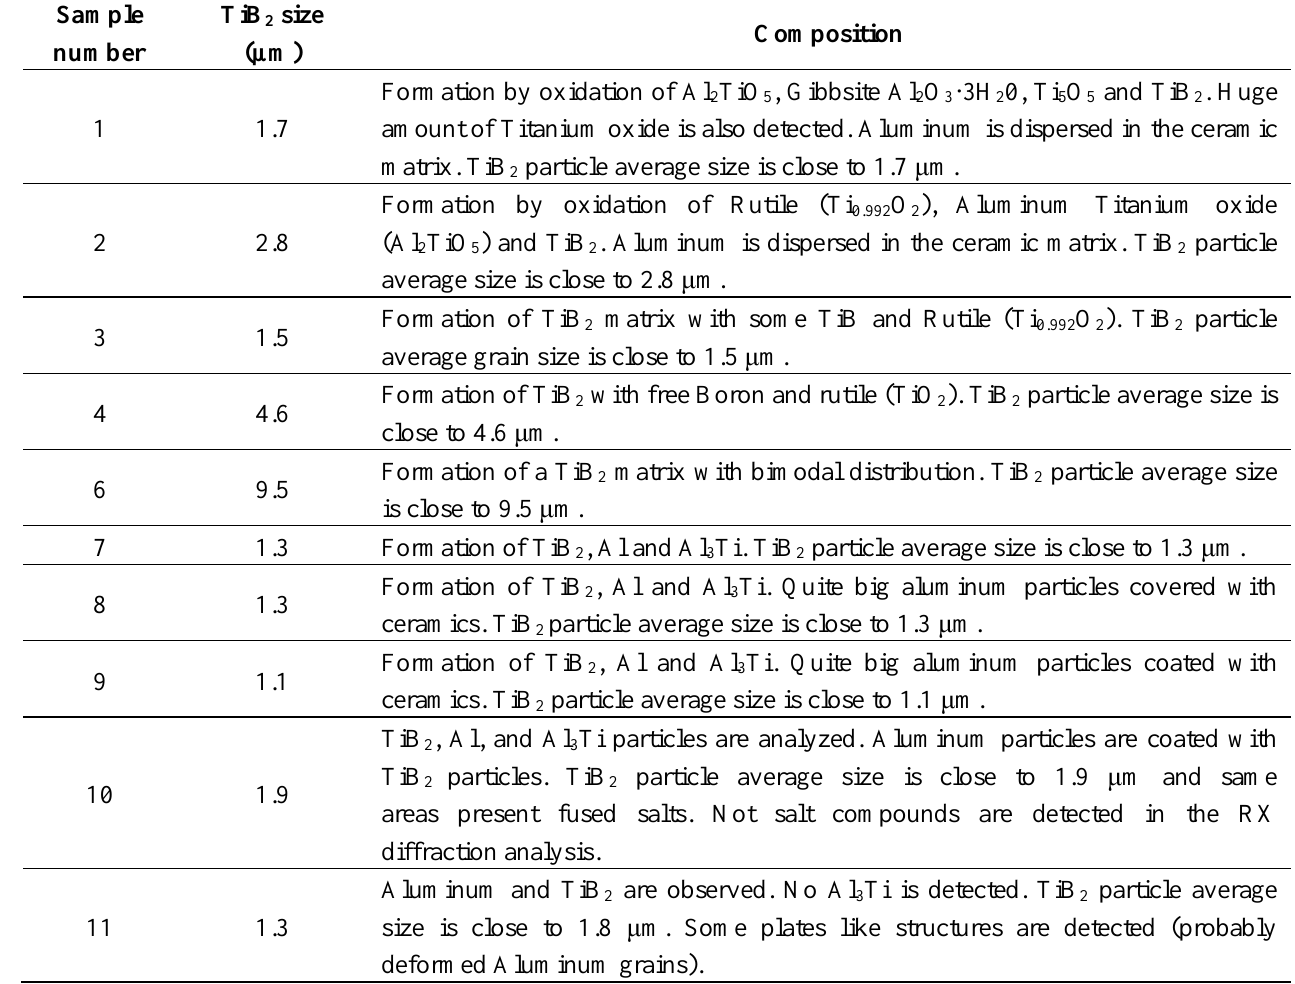
Table 3. Average TiB2 particle size of the fabricated master